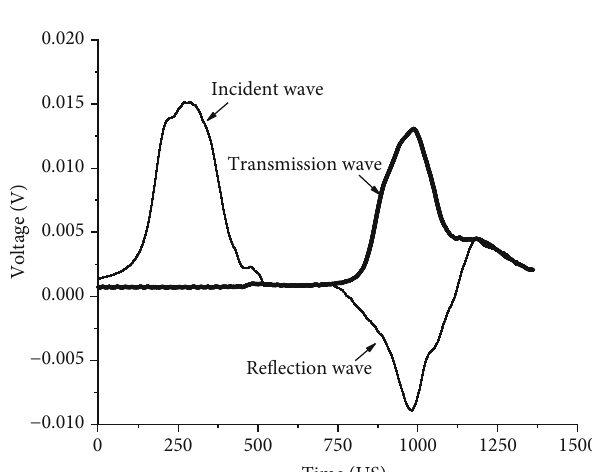
Figure 1: SHPB test device.